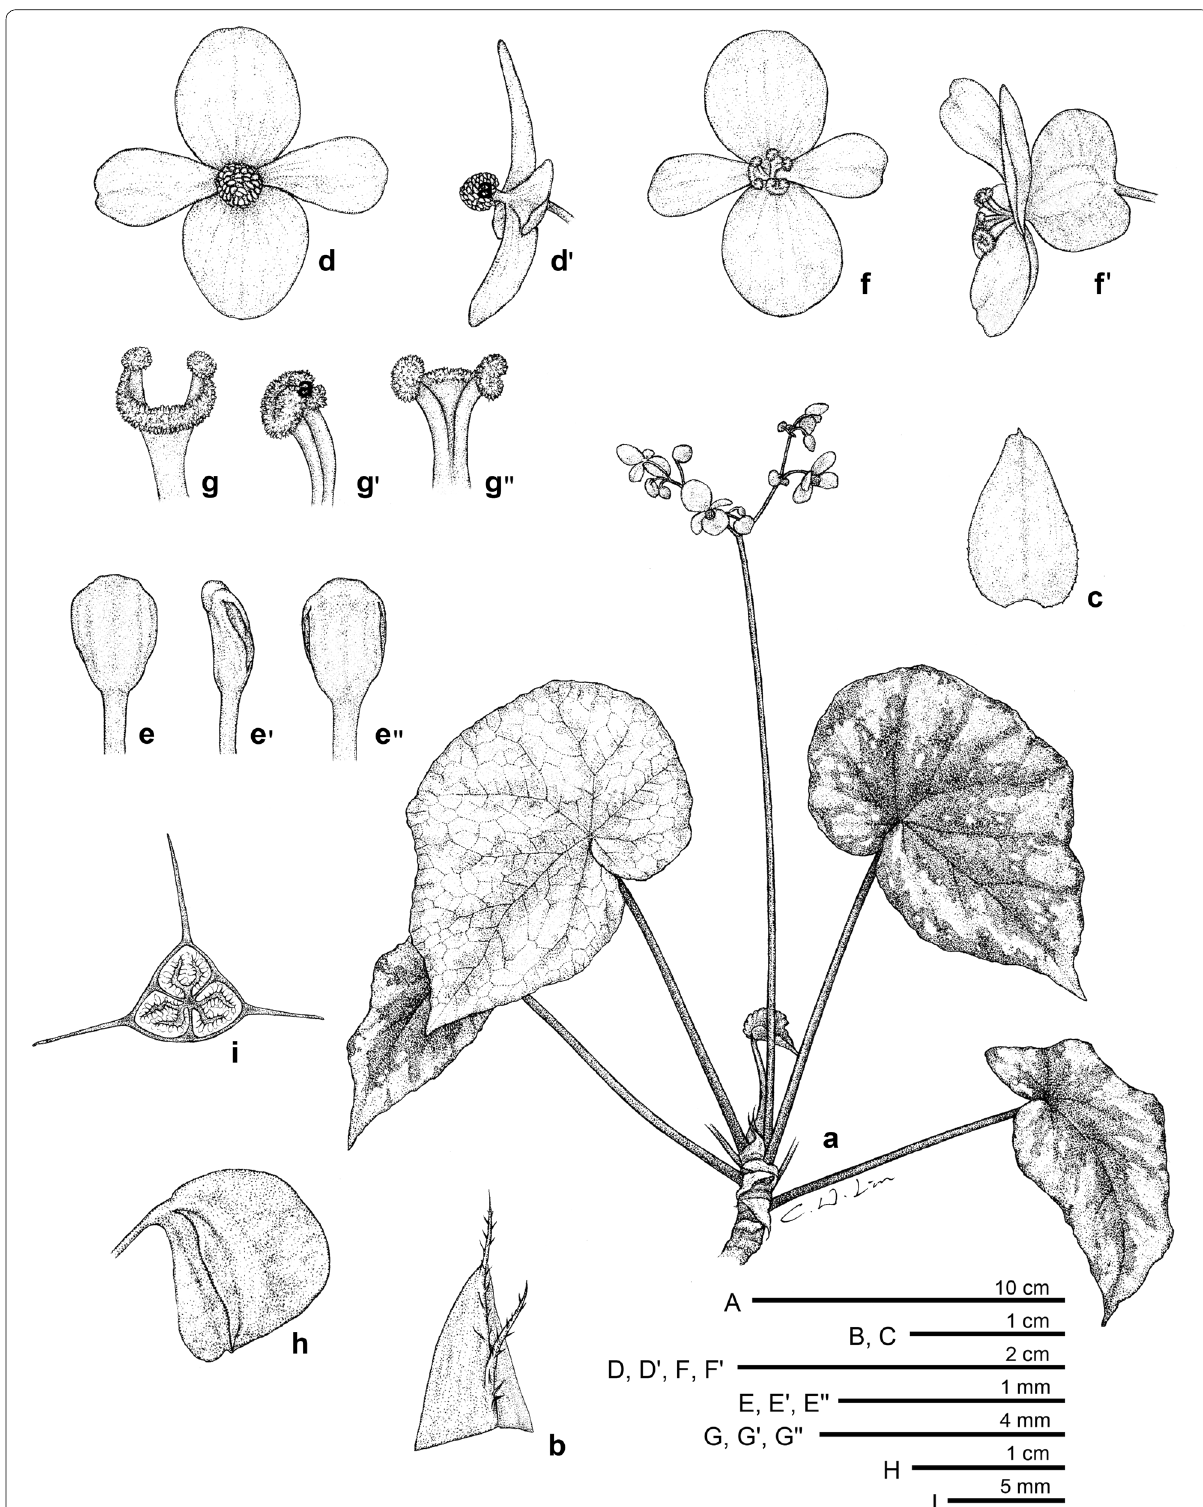
Fig. 5 Begonia sykakiengii R. Rubite, C.‑I Peng, C.W. Lin & K.F. Chung . A habit; B stipule; C bract; D , D ′ staminate flower, face and side views; E , E ′ , E ′′ stamen, dorsal, side and ventral views; F , F ′ pistillate flower, face and side views; G , G ′ , G ′′ style and stigmatic band, dorsal, side and ventral views; H capsule; I cross section of an immature